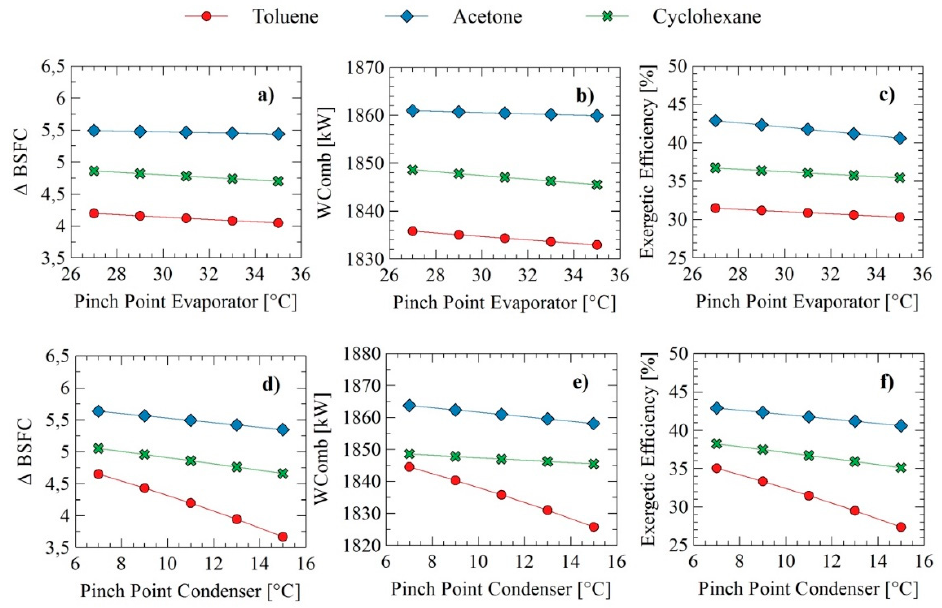
Figure 4. Effect of the evaporator and condenser pinch point on ( a , d ) ∆ BSFC, ( b , e ) Wcomb, and ( c , f ) exergetic efficiency using toluene, acetone, and cyclohexane as working fluid.